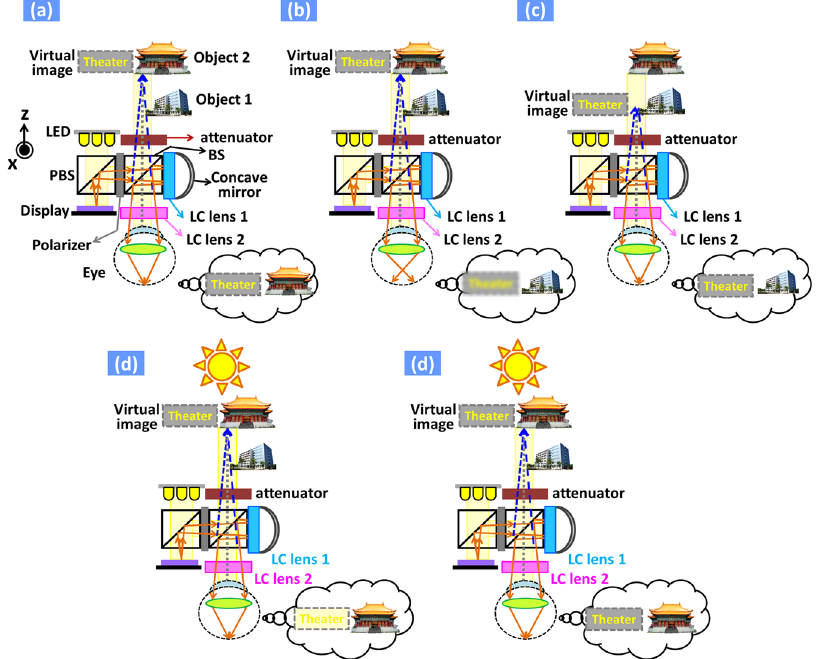
Figure 1. Operating principles of the AR system. ( a ) Initially, “LC lens 1”, “LC lens 2”, and attenuator are off. People see the “object 2” and the virtual image “Theater” projected from the display. ( b ) When “LC lens 2” turns on and provides a positive lens power to the system, people see the “object 1”, but the virtual image is blurred. ( c ) From ( b ), the “LC lens 1” then turns on and provides a positive lens power, the virtual image is shifted to the location of “object 1”. People see both of the virtual image and “object 1”. ( d ) From ( a ), the virtual image is washed out under strong ambient light. ( e ) From ( d ), people can see the virtual image when the attenuator